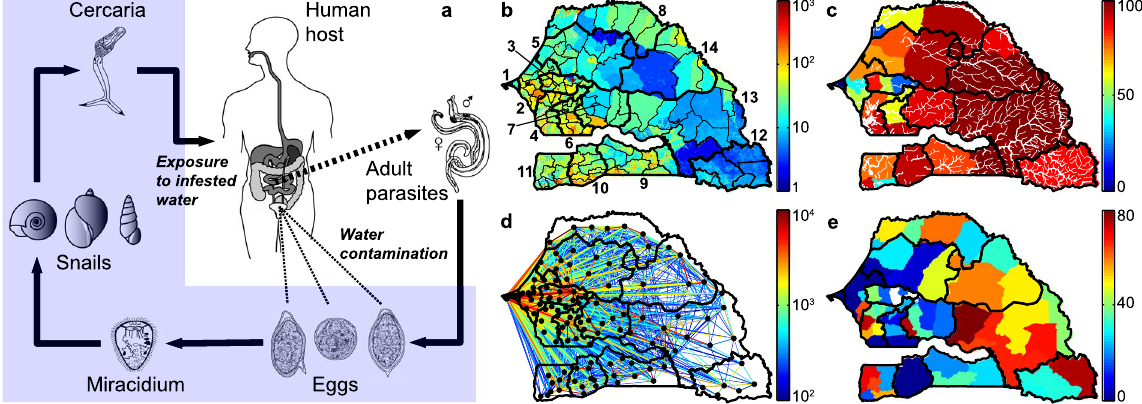
Figure 1. Schistosomiasis transmission cycle ( a ) and data for model application ( b – e ). ( a ) Paired adult worms within human hosts produce eggs (left to right: S . mansoni , S . japonicum , S . haematobium ) that are shed through feces or urine and hatch into miracidia. Miracidia infect species-specific intermediate snail hosts (left to right: genus Biomphalaria , Bulinus , Oncomelania ), which then shed free-swimming cercariae that can penetrate human skin and eventually develop into reproductive schistosomes. ( b ) High-resolution population density map of Senegal [inhabitants km − 2 ]. Black lines indicate administrative boundaries (thick/thin lines are for regions/arrondissements). Regions are numbered as follows: 1–Dakar, 2–Thiès, 3–Diourbel, 4–Fatick, 5–Louga, 6–Kaolack, 7–Kaffrine, 8–Saint-Louis, 9–Kolda, 10–Sédhiou, 11–Ziguinchor, 12–Kédougou, 13–Tambacounda, 14–Matam. ( c ) People living in rural settings [%] (colors) and rivers of Senegal (thick/thin white lines are for perennial/ephemeral rivers). ( d ) Human mobility fluxes in year 2013 [number of people] estimated from anonymous mobile phone traces; the flux between any two arrondissements (say i and j , ≠ i j ) is obtained as K i Q ij (see Table 1). Only fluxes ≥ 100 people are displayed as links between arrondissement-level population centroids. ( e ) Prevalence of urogenital schistosomiasis [% of infected people] according to the national surveys operated by the Senegalese Ministry of Health. Data are shown at the scale of health districts and cover the timespan 1996–2013. See SI for details on data sources. The drawings in panel a are from the Centers for Disease Control and Prevention (CDC, Parasites: Schistosomiasis, http://www.cdc.gov/parasites/schistosomiasis/ biology.html; last date of access: 03/02/2017). The maps in panels b–e have been created with QGIS 2.4 (QGIS Development Team, QGIS: A free and open source geographic information system, http://www.qgis.org/; last date of access: 03/02/2017) and MATLAB R2015b (MathWorks, MATLAB, http://www.mathworks.com/ products/matlab/; last date of access: